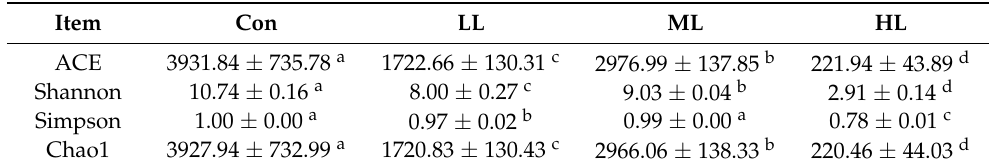
Table 5. Alpha diversity of intestinal microbiota of juvenile largemouth bass fed the experimental diets for 28 days *.